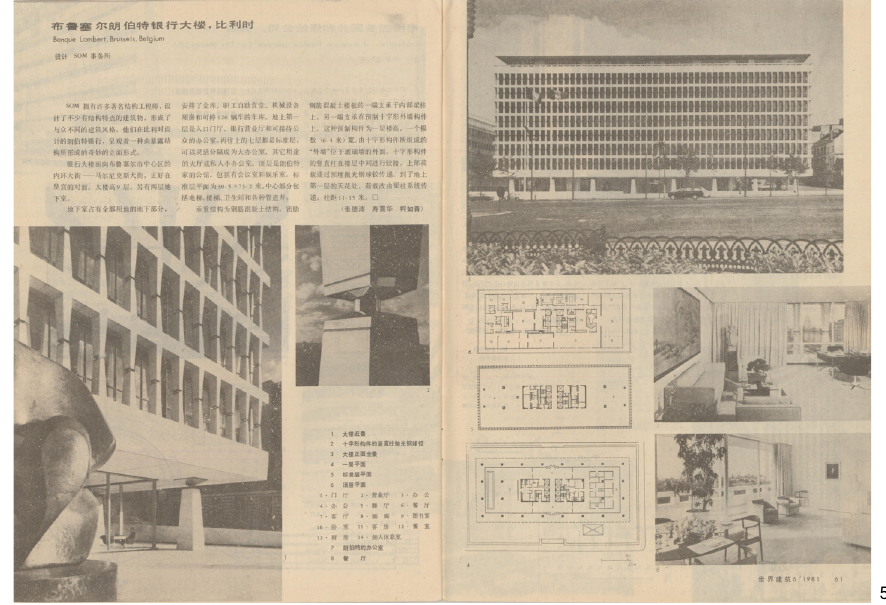
Content of Shìjiè Jiànzhú , 1981, no.